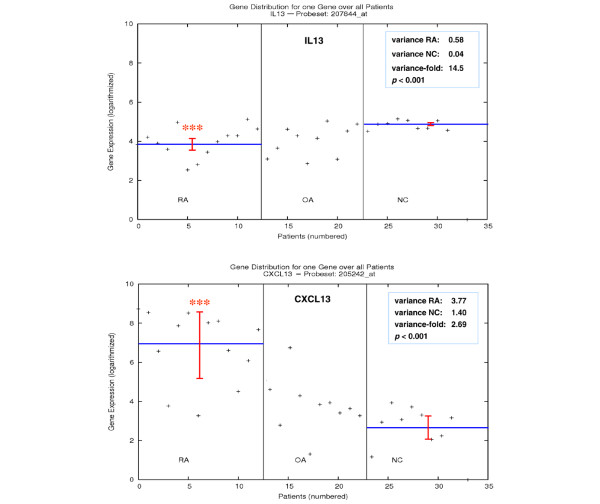
Gene-specific inter-individual gene expression variances. The graph shows the individual gene expression level of rheumatoid arthritis (RA) (n = 12) and osteoarthritis (OA) (n = 10) patients as well as normal control (NC) donors (n = 9) for IL13 and CXCL13 (cytokine–cytokine receptor interactions). The mean gene expression (blue line) and the intra-group inter-individual variances in RA and NC synovial membrane (red bar) are indicated, resulting in significantly enhanced variances among patients within the RA group (P < 0.001, Bonferroni/Holm corrected Brown-Forsythe version of the Levene test).